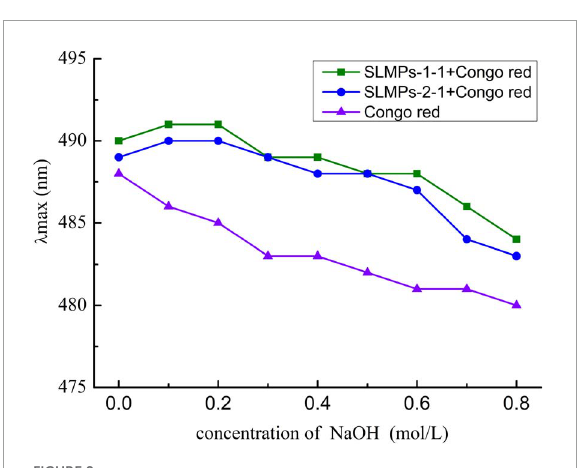
FIGURE8 Conformation transition analysis of SLMPs-1-1 and SLMPs-2-1 at different concentration of